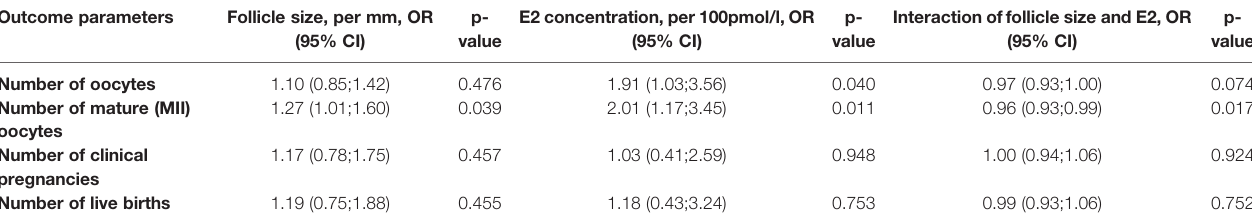
TABLE 3 | Association of outcome parameters with follicle size and E2 concentration and interaction of both. Outcome